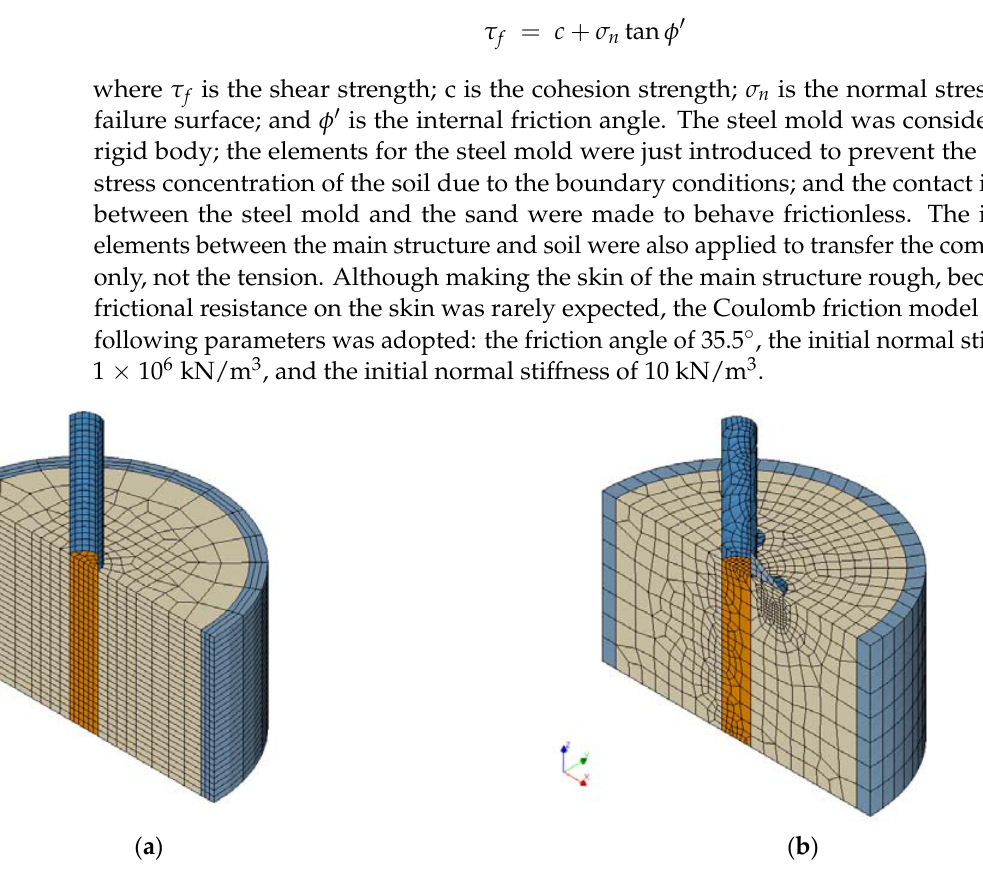
Figure 6. Finite element models of physical test models: ( a ) monopile ( b ) hybrid monopile; where each color indicates mesh for a part; greyish blue: cylindrical steel mold, sorrel brown: soil foundation, yellowish orange: soil in and beneath monopile, and cool blue: monopile and supplemental support.